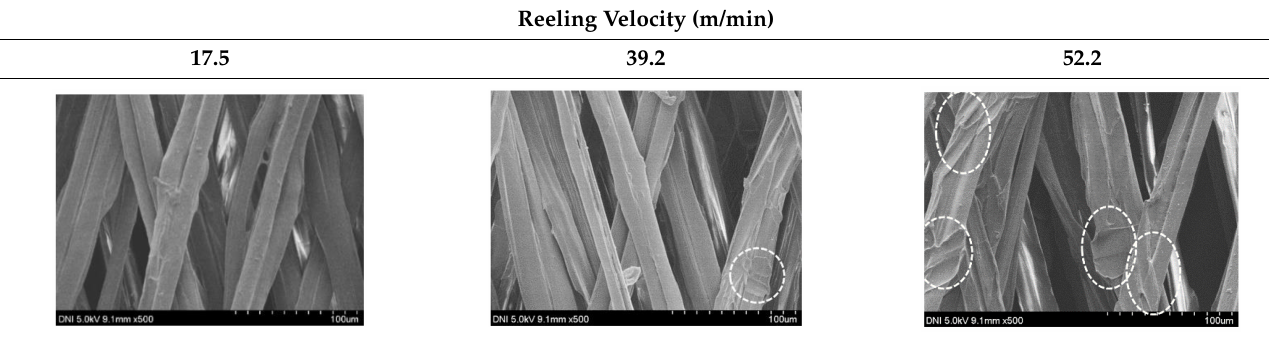
Table 2. FE-SEM images of the silk webs prepared at various reeling velocities. Reeling bath temperature was 50 ◦